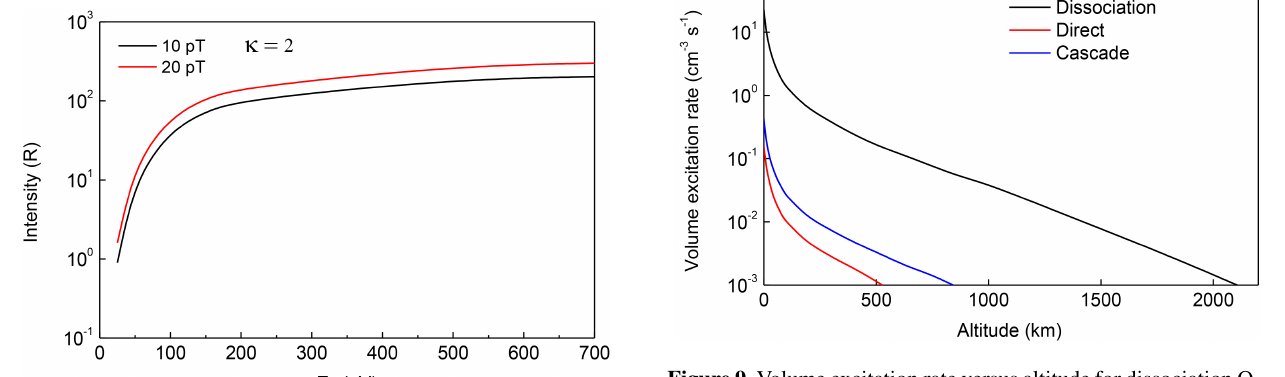
Figure 9. Volume excitation rate versus altitude for dissociation O 2 , direct O ( 5 S ) and cascading O ( 5 P ) excitations. A Maxwellian dis- tribution with T h = 150eV is used, and whistler mode wave ampli- tude is